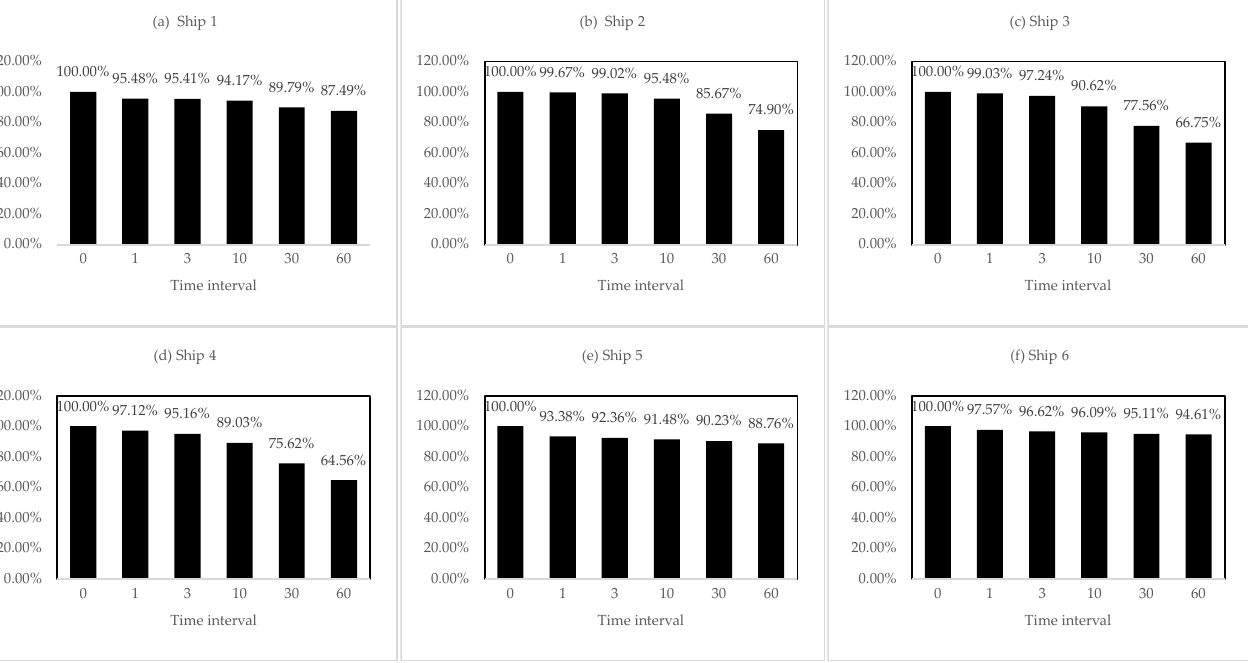
Figure 5. Emissions of CO 2 for the six ships in one year without thinning (0 min) and with thinning at time intervals of 1, 3, 10, 30, and 60 min. ( a ) Ship 1 ( b ) Ship 2 ( c ) Ship 3 ( d ) Ship 4 ( e ) Ship 5 ( f ) Ship 6. (2) The thinning of AIS data has a more significant impact on the pollutant emissions of ships with acutely fluctuating speeds. After the data are thinned, the order of the reduction of air pollutant emissions from ships is: in-and-out port ships > maneuvering ships > cruise ships (see Figures 4 and S1–S5 in Supplementary